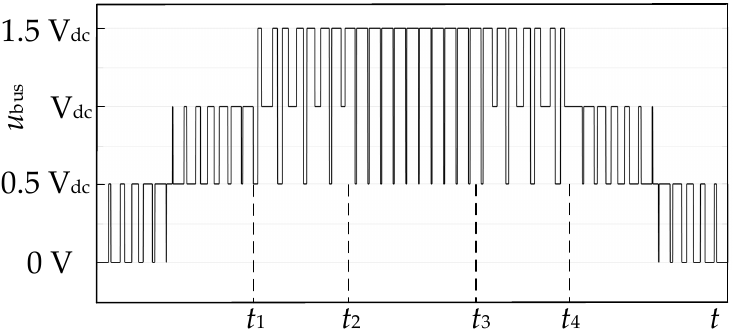
Figure 6. The new modulation wave in the positive half cycle (switching frequency f s = 5 kHz). According to the original modulation method, there are two choices in a switching period when u ref > V dc . These choices are u bus = V dc and u bus = 1.5 V dc . In this paper, this condition is expressed as u bus (cid:15) {V dc , 1.5 V dc }. u bus (cid:15) {0.5 V dc , 1.5 V dc } is added when